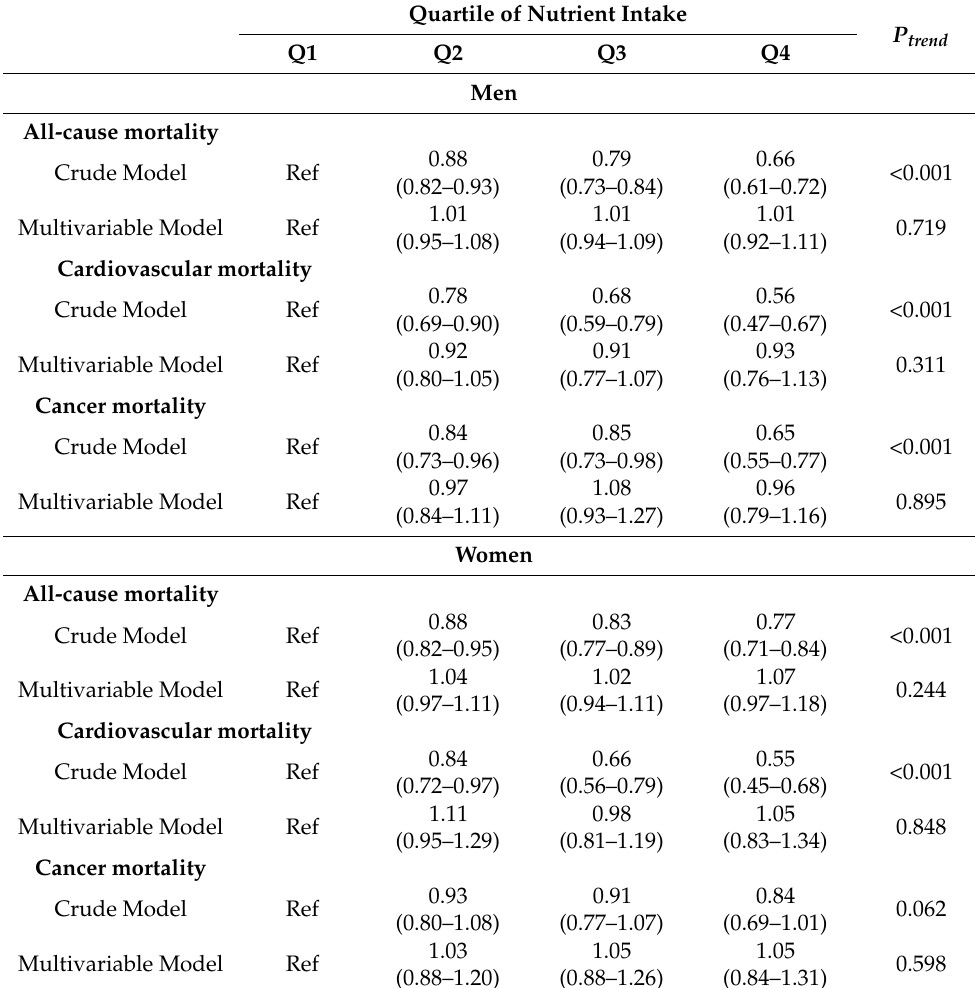
Table 4. Hazard Ratios (HRs) and 95% confidence intervals (CIs) for all-cause and cause-specific mortality according to the quintiles of dietary vitamin